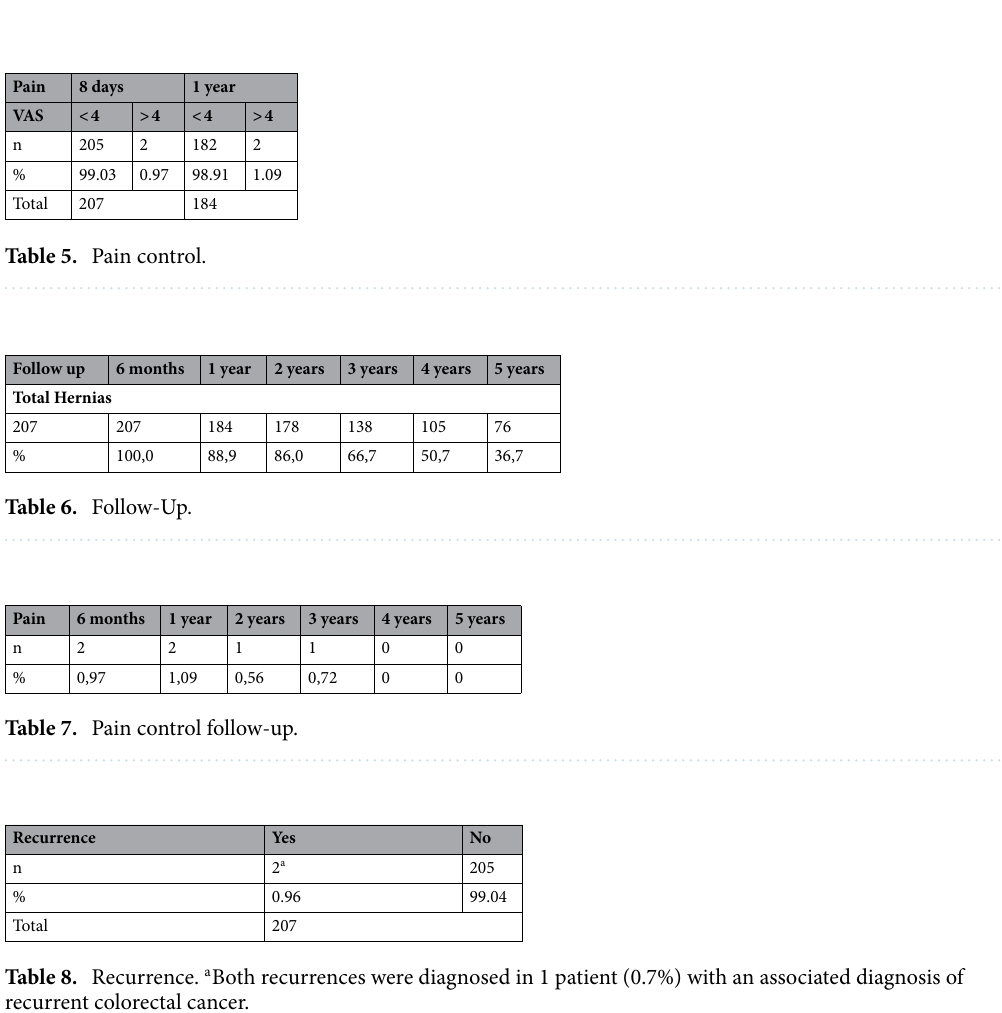
Table 4. Postoperative qualitative variables.